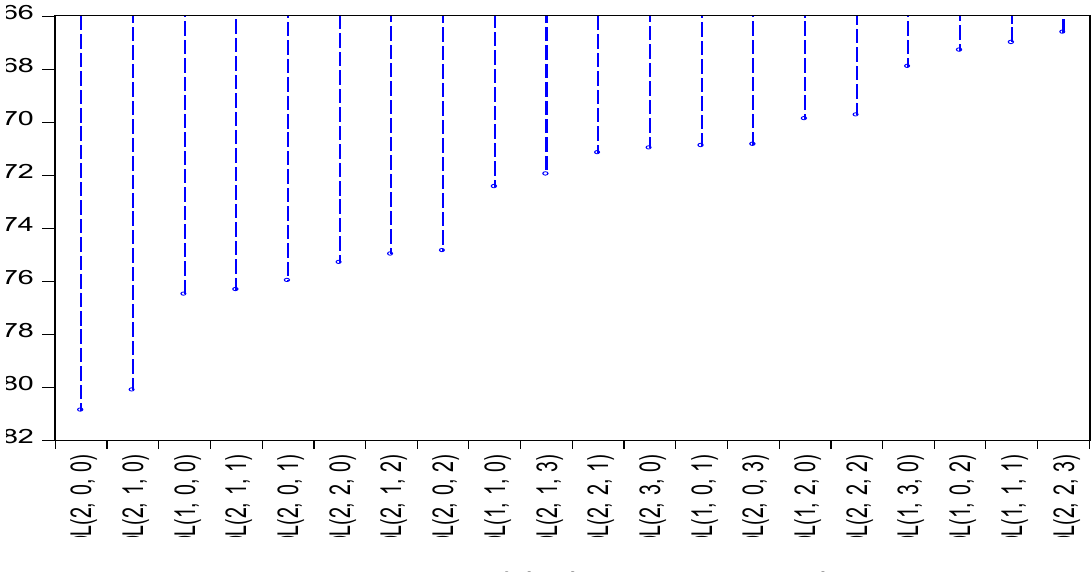
Figure 2: ARDL Model Selection Criteria